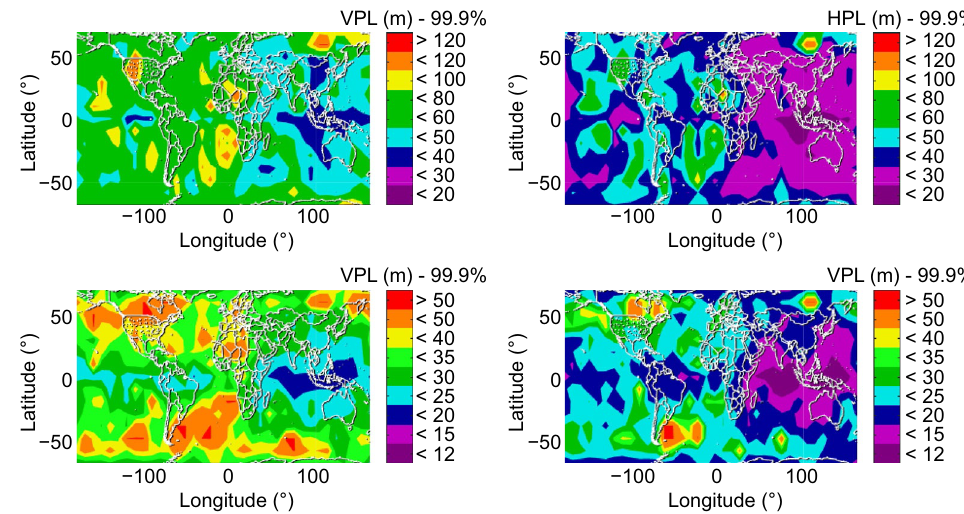
Fig. 2 VPL (top) and HPL (bottom) (right) for SPP model (left) and PPP-WAR model (right) as a function of user location